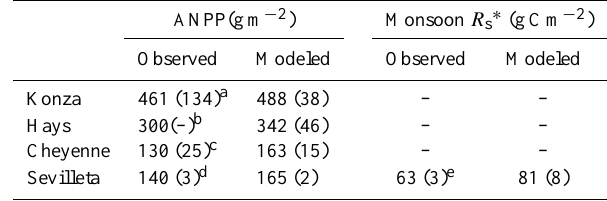
Table 2. Comparisons between modeled and measured above- ground net primary production (ANPP) and soil respiration ( R s ).